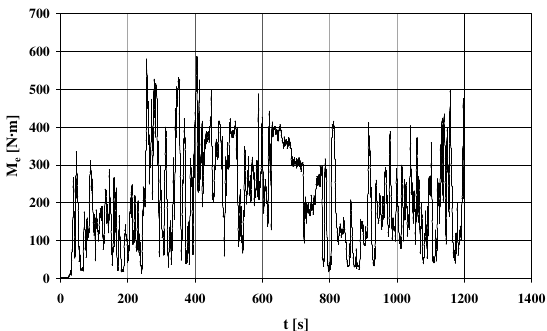
Fig. 6. Engine torque – M e vs. time – t curve, recorded in the BRDT test